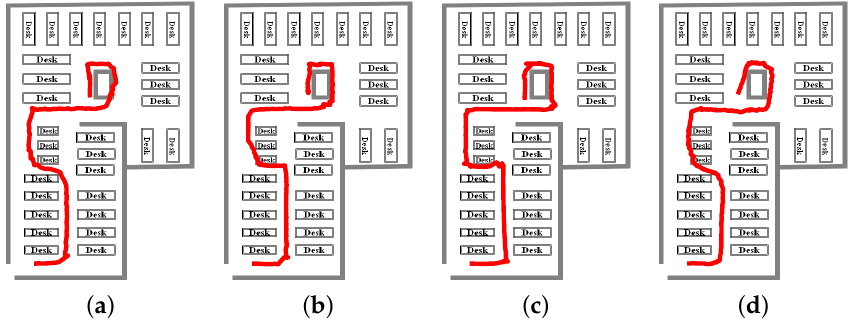
Figure 10. Positioning results for WLS: ( a ) calling; ( b ) dangling; ( c ) handheld; ( d ) pocket.